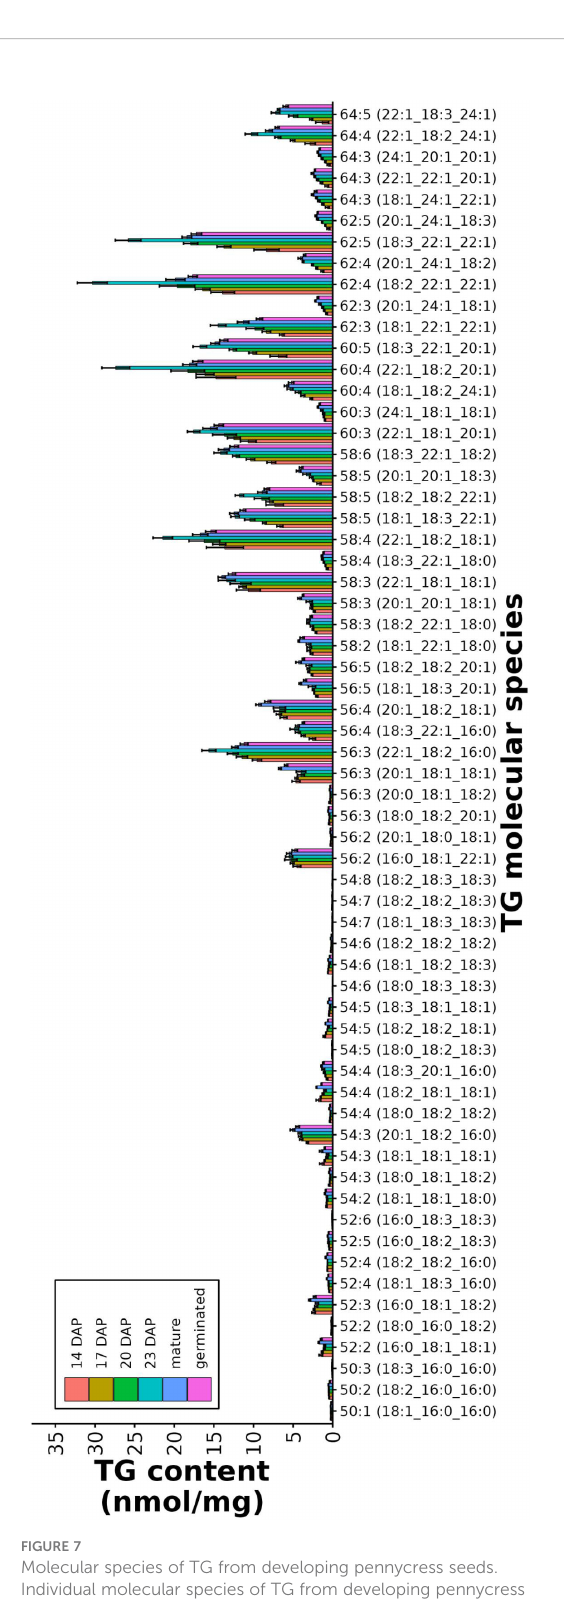
FIGURE 7 Molecular species of TG from developing pennycress seeds. Individual molecular species of TG from developing pennycress seeds at 14, 17, 20, and 23 DAP, as well as mature and germinated